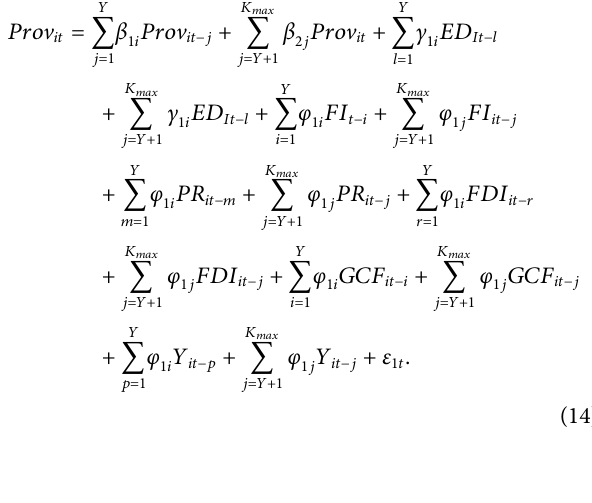
TABLE 9 | Results of OLS, fi xed effects, and random effects. Ordinary least square Fixed effects Random